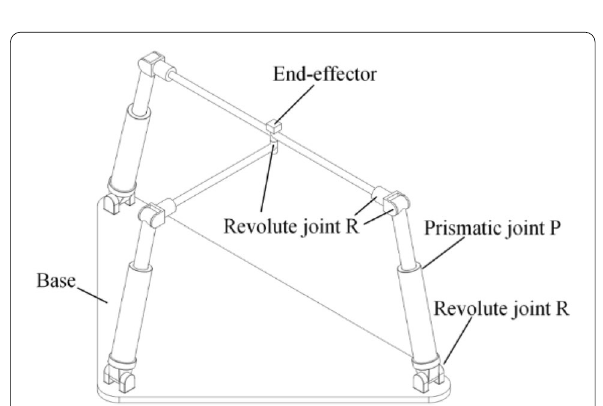
Figure 11 The modified PM containing the fewest single